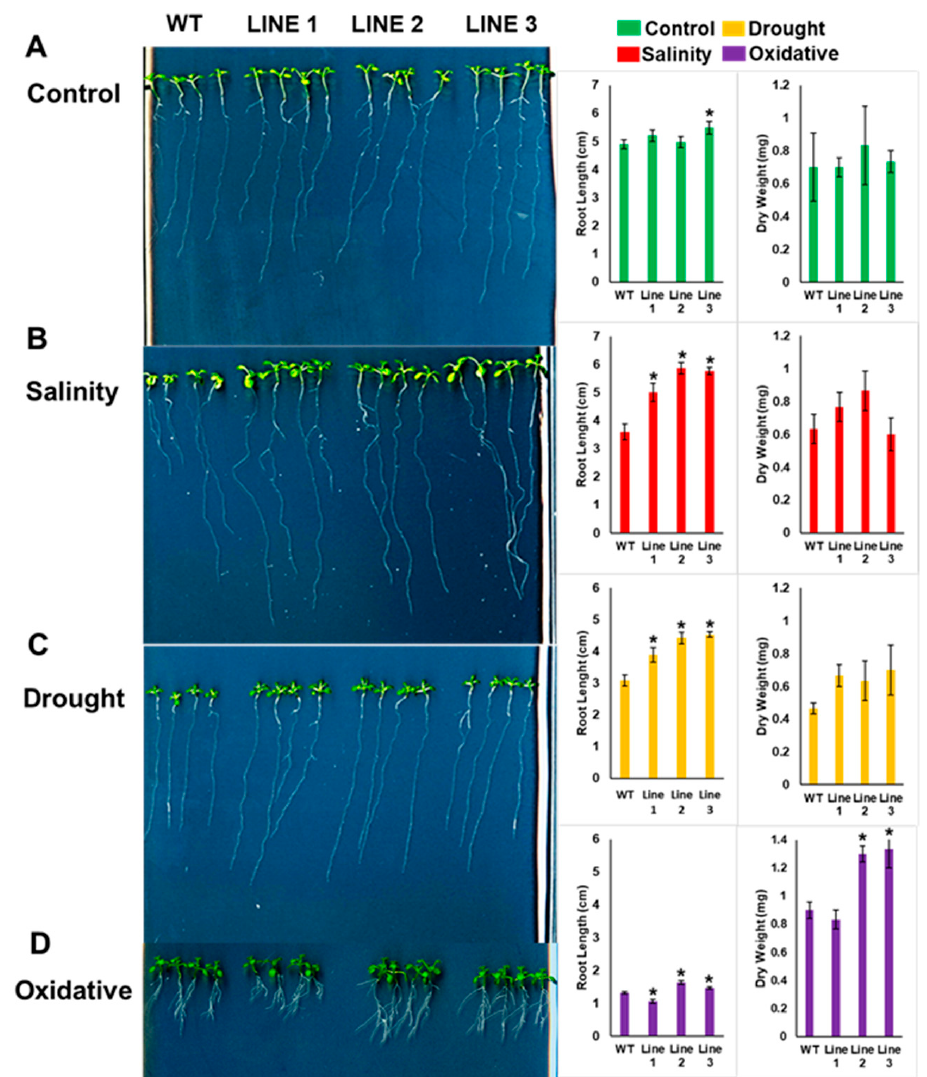
Figure 5. The effect of PdMT2A on the phenotype of the transgenic Arabidopsis seedlings. The growth pattern, root length and dry weight of the WT and PdMT2A transgenic Arabidopsis lines were measured when the seedlings were grown on plain half-MS plates as a control ( A ) or on half-MS plates supplied with 100 mM NaCl ( B ), 150 mM mannitol ( C ) or 2 mM H 2 O 2 ( D ), for 14 days. The length of the main root was measured manually using a standard centimeter scale. The bars represent either the mean root length in cm or the dry weight in mg (± SE, n = 3), while the asterisks indicate a significant difference from WT plants ( p < 0.05).